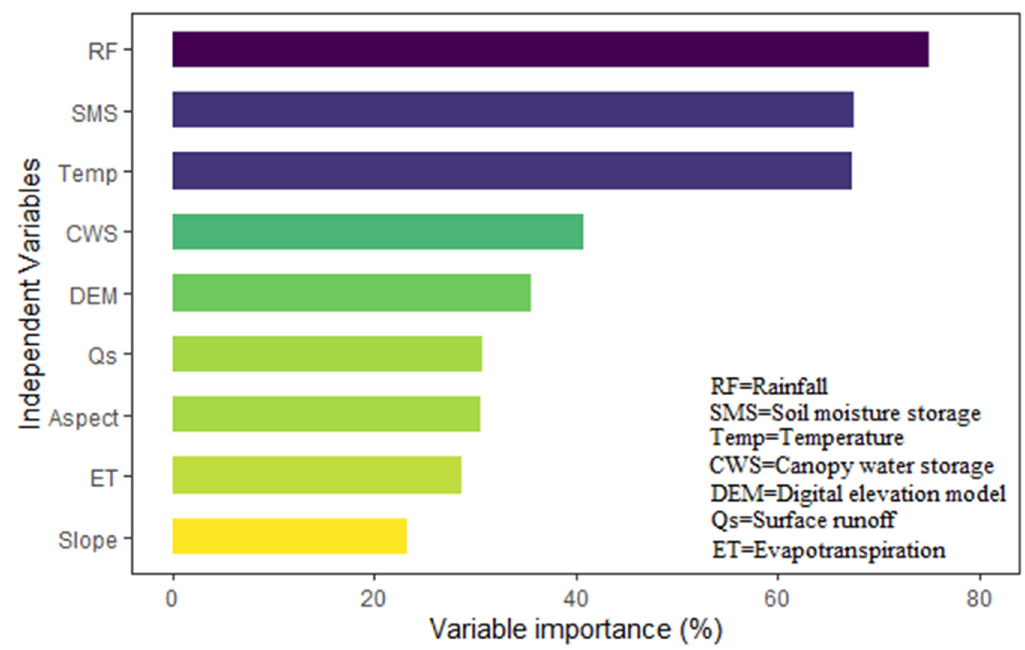
Figure 5. Importance measures predictive (VIMP) test of the independent variables.